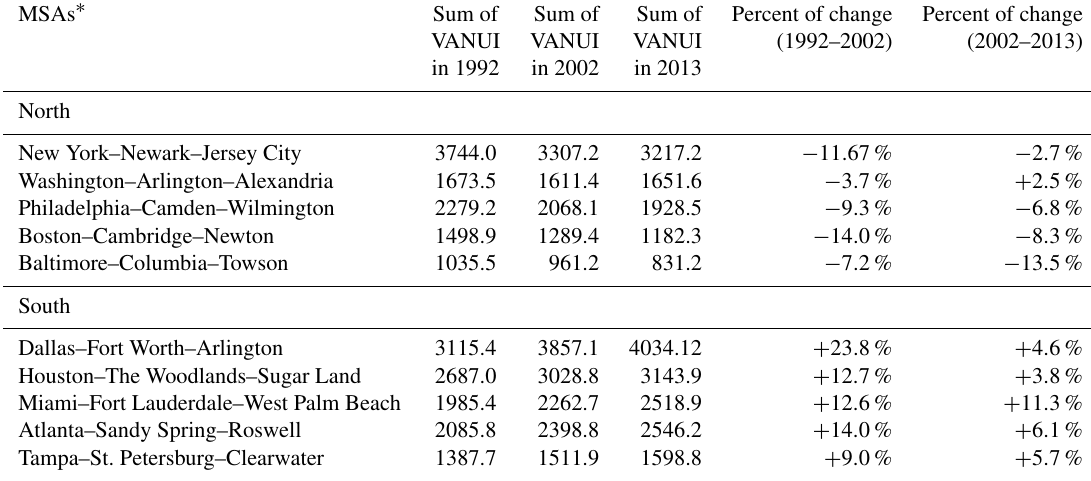
Table 4. Sum of VANUI value and change percentage in the top five most-populated MSAs in the north and south of the study area. MSAs ∗ Sum of Sum of Sum of Percent of